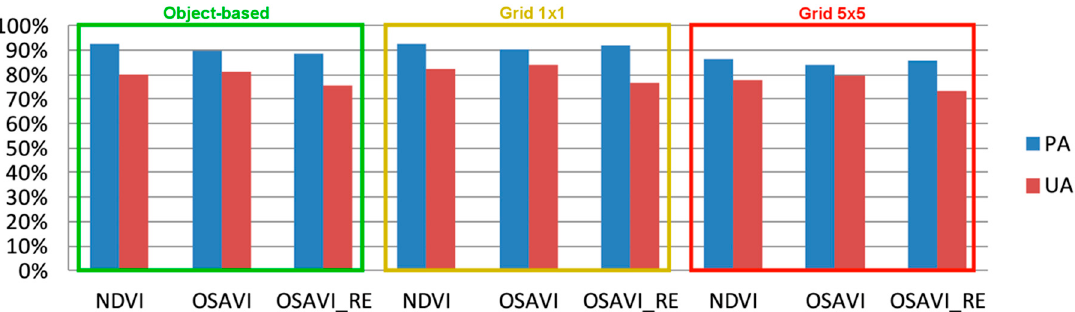
Figure 12. Producer’s (PA) and user’s (UA) accuracy of the detected damaged crops, without the ff erent resolution of input data in the second approach (1 × 1 influence of roads, with three different resolution of input data in the second approach (1 × 1 m). influence of roads, with three di